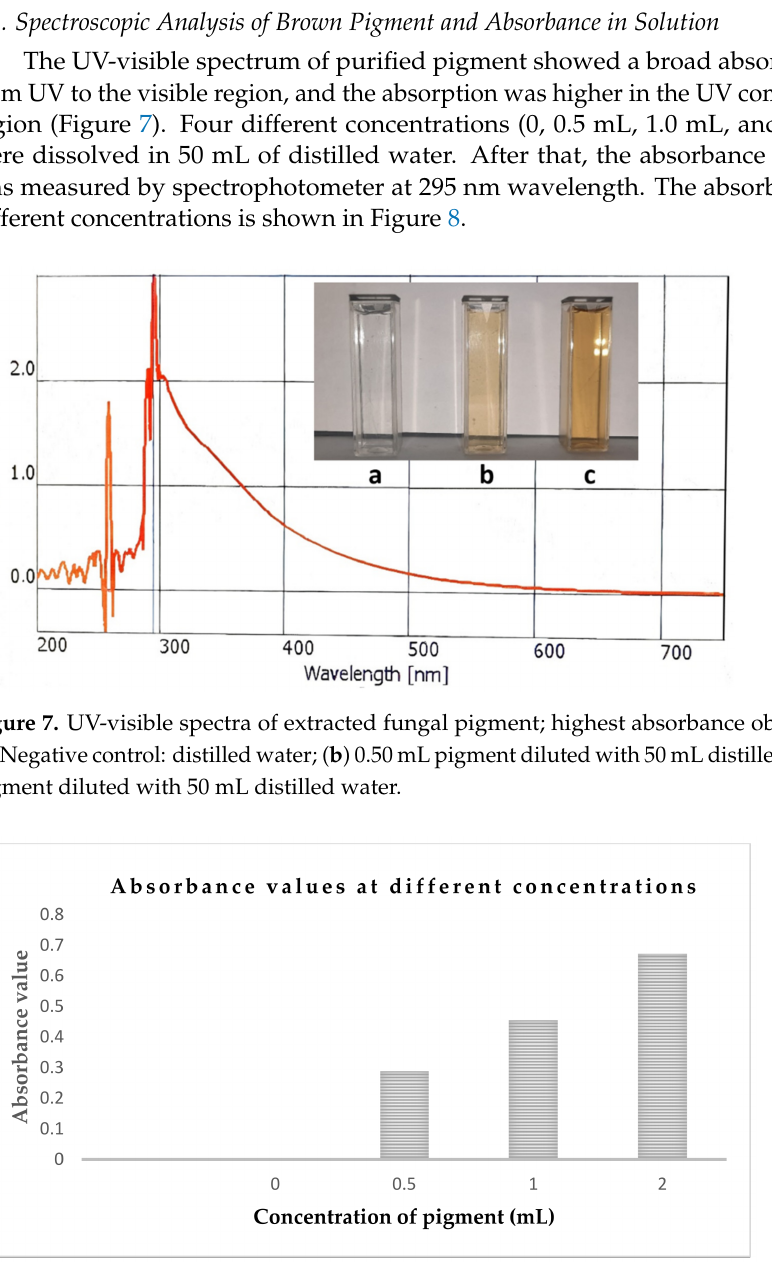
Figure 8. Absorbance values at different concentrations (0, 0.5 mL, 1.0 mL, and 2 mL) of diluted pigments in 50 mL of distilled